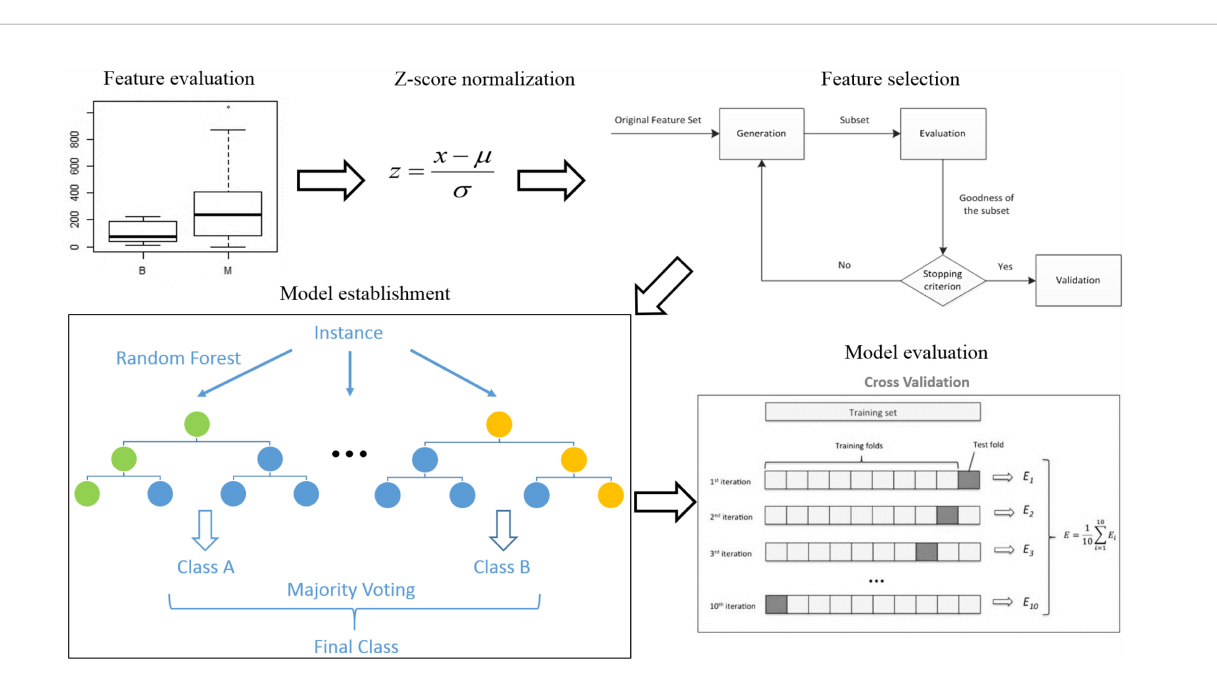
FIGURE 2 | Data analysis and model establishment process.